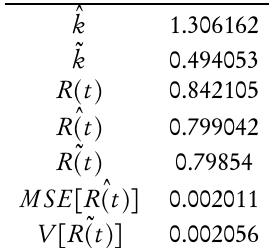
Estimates of k and R(t), variance and MSE under type I